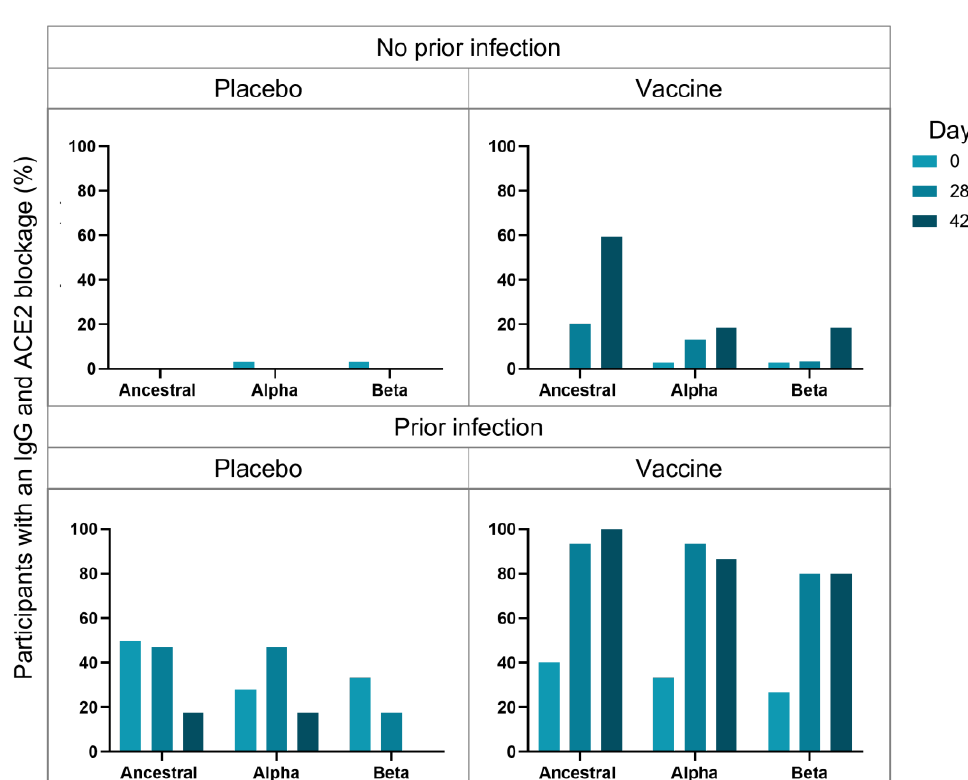
Figure 3. The longitudinal (Day 0, Day 28 and Day 42) change in the percentage of participants with both an IgG response and who have antibodies that blocked ACE2 binding to the ancestral, Alpha/B.1.1.7 and Beta/B.1.351 SARS-CoV-2 spike (S) protein variants are depicted. Participants were vaccinated at Day 0 and Day 28, and serum collected before vaccine administration at Day 0, Day 28 and Day 42, and assessed based on division into a placebo or vaccine-receiving groups, with or without a prior infection.